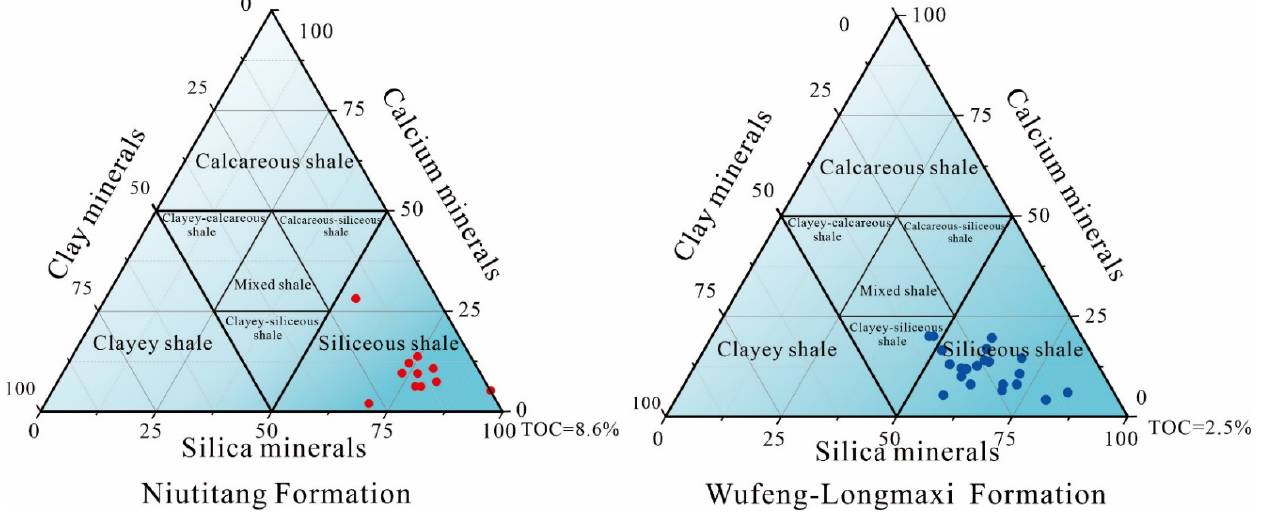
Figure 4. Lithofacies distribution characteristics of samples between the Wufeng-Longmaxi For- mation and the Niutitang Formation in northern Guizhou Province [41].